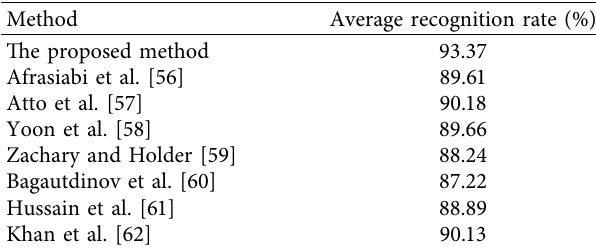
Table 2: Compared with other approaches on the Vlog dataset.